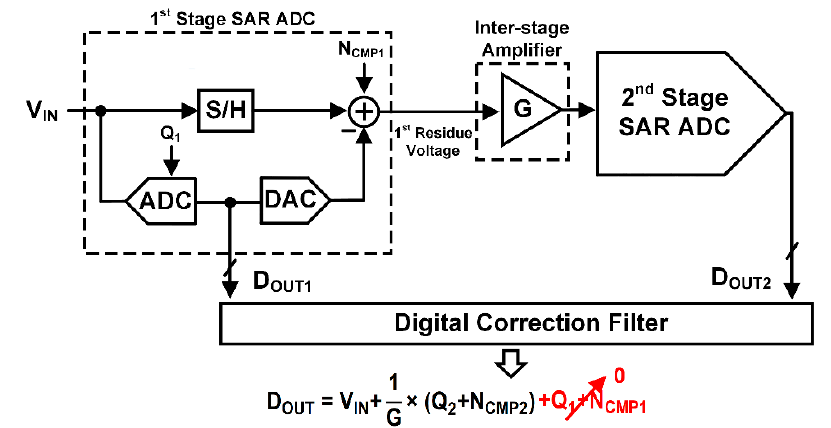
Figure 1. The conventional pipelined SAR ADC block diagram.